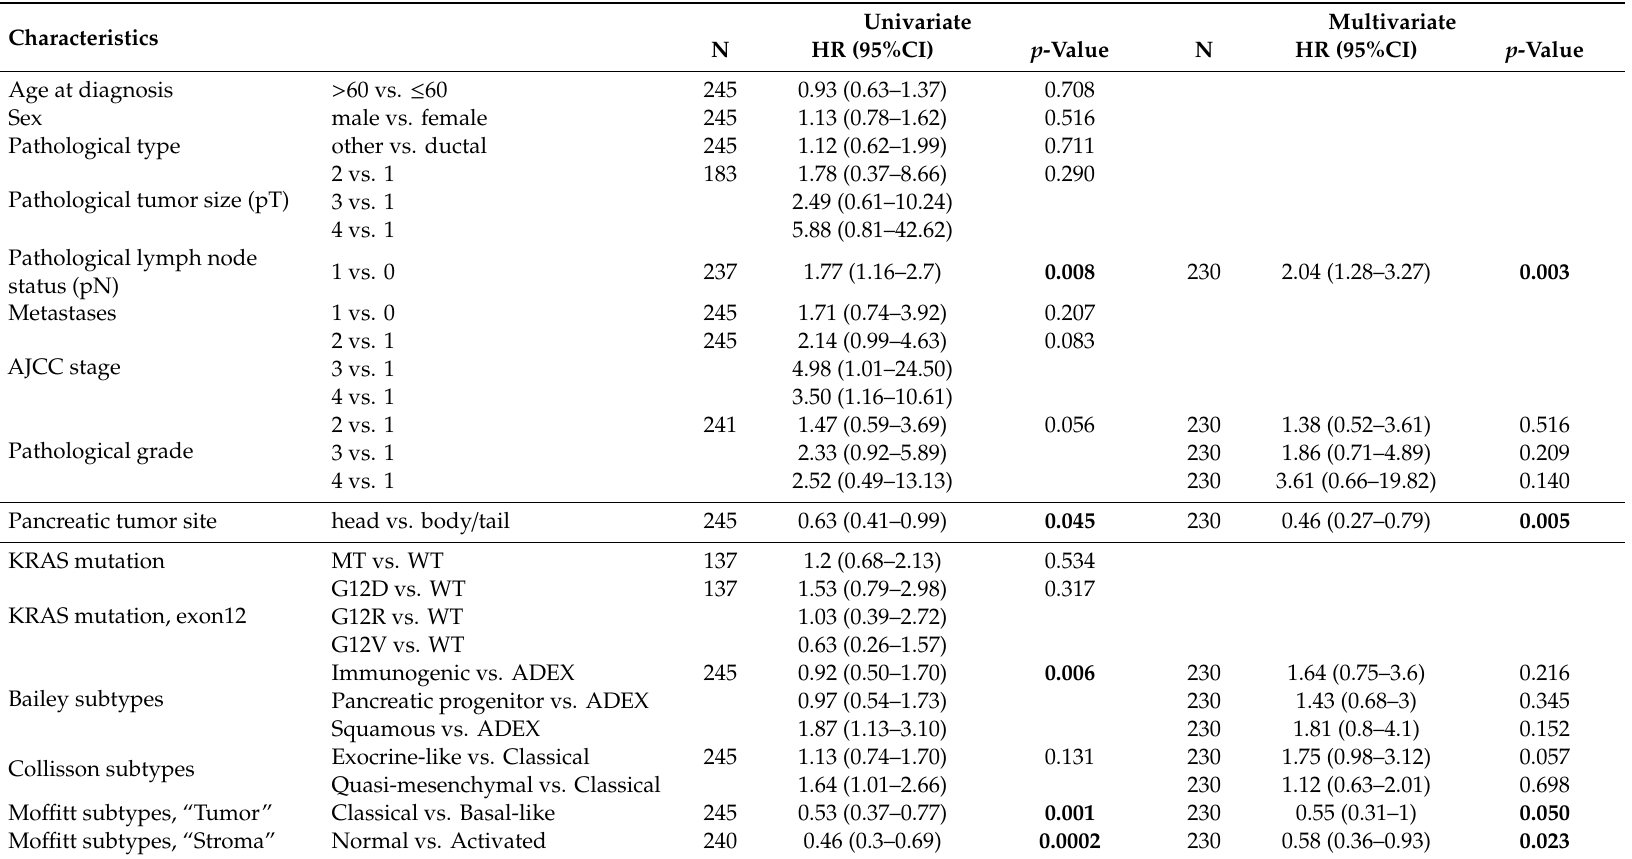
Table 2. Uni- and multivariate Cox regression analyses for overall survival (validation